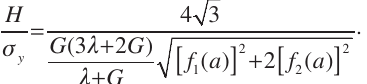
Table 1 Experimental measurements of hardness for W in very small indentation depths [10] . For the determination of H / σ value of 859 MPa was used for σ